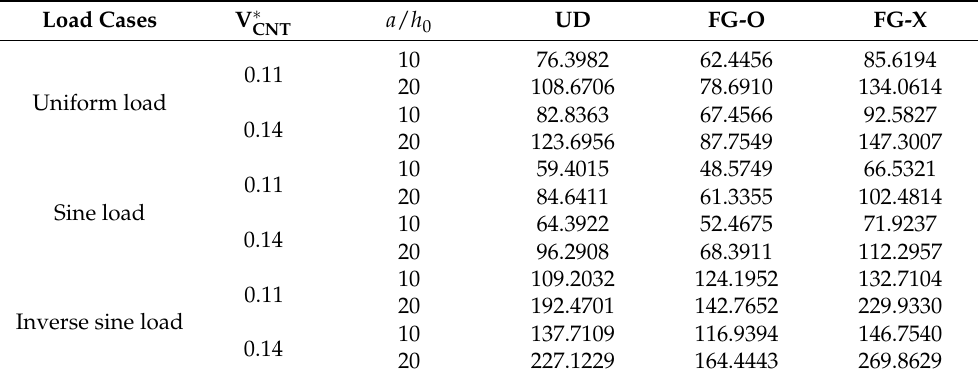
Table 4. The effects of the CNT distributions, CNT volume fractions, and length to thickness ratio on the variations of the dimensionless biaxial buckling load of the FG-CNTRC microplate under uniform and nonuniform edge loads (SSSS).